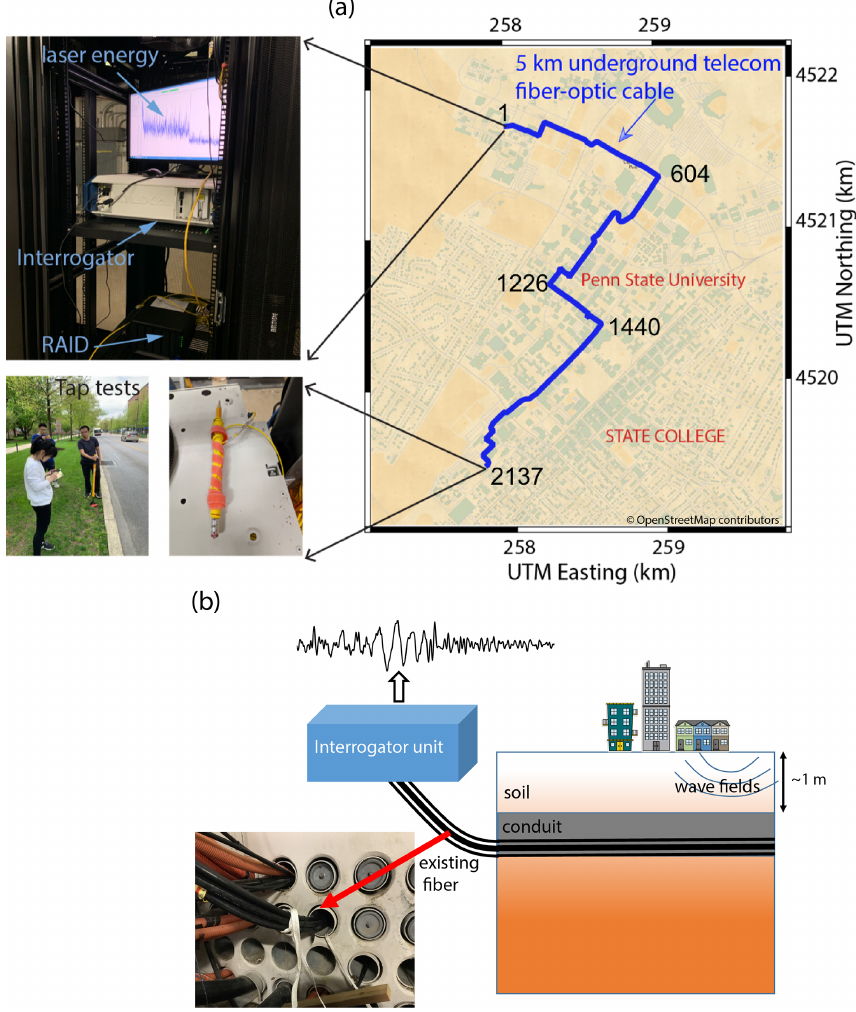
Figure 1. (a) Penn State fiber-optic distributed acoustic sensing (DAS) array map. Numbers listed along the array denote the channel number. Top left: DAS field setup; bottom left: a photo of tap tests; bottom right: the fiber end. (b) Illustration of DAS array connecting existing fiber optics. The bottom left subfigure shows the pre-existing fiber-optic cable (in black) used for this project. Map © OpenStreetMap contributors 2020. Distributed under a Creative Commons BY-SA